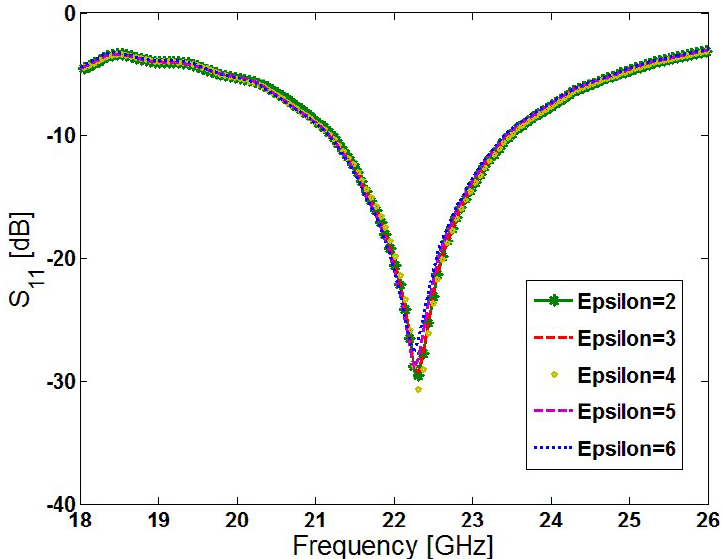
Figure 17. S 11 results of the array for various values of Epsilon (ε r ).